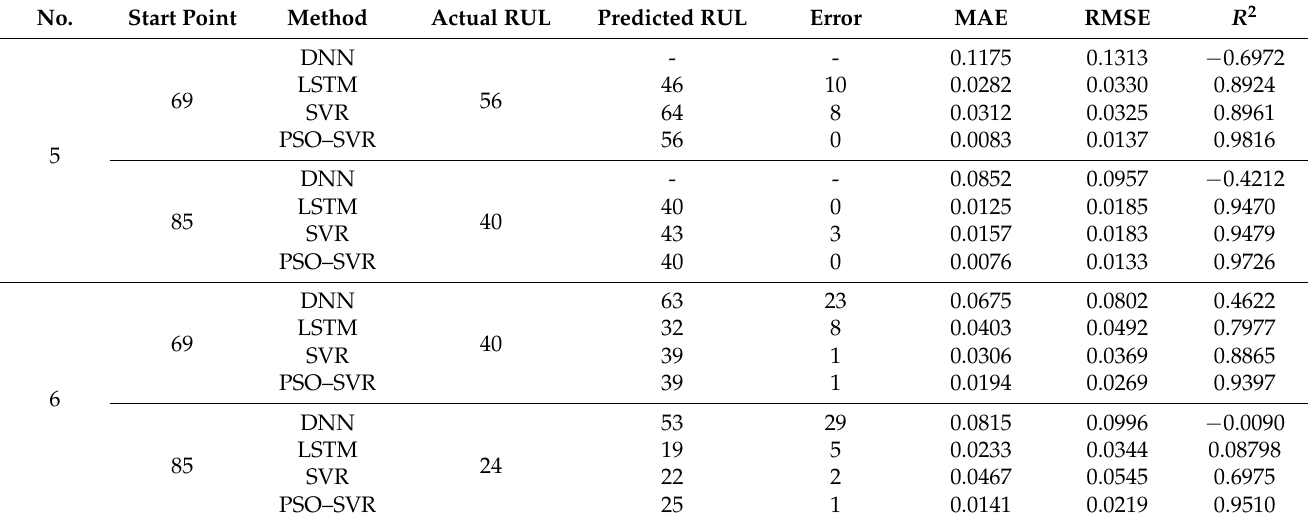
Table 4. Comparison of the results of the different prediction